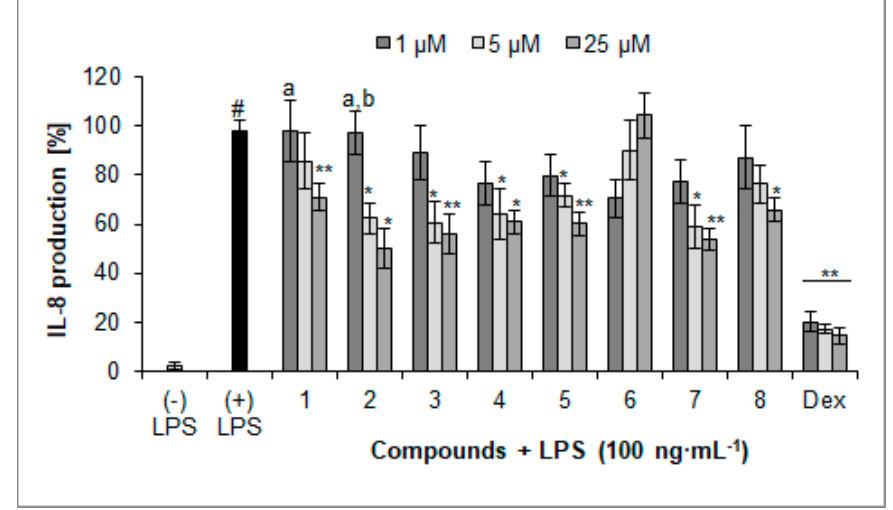
Figure 4. Inhibition of IL-8 production (%) by isolated compounds 1 – 8 in LPS-treated PMNs (mean